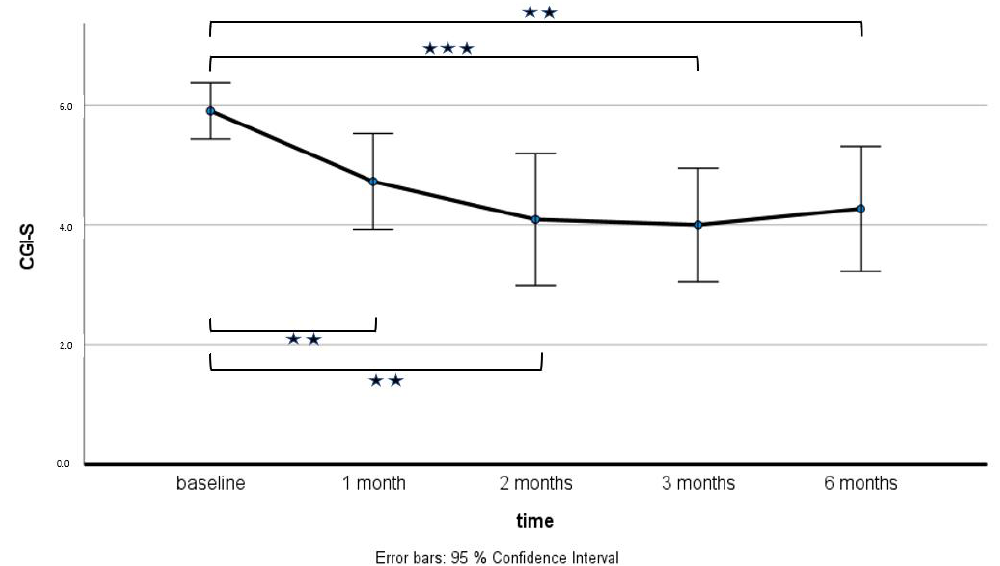
Figure 3. Comparison of Clinical Global Impression—Severity (CGI-S) between five points of obser- vation: before the treatment, one month, two months, three months and six months after the initiation of lurasidone augmentation of clozapine in a group of 11 patients with schizophrenia. ** p ≤ 0.01; *** p ≤